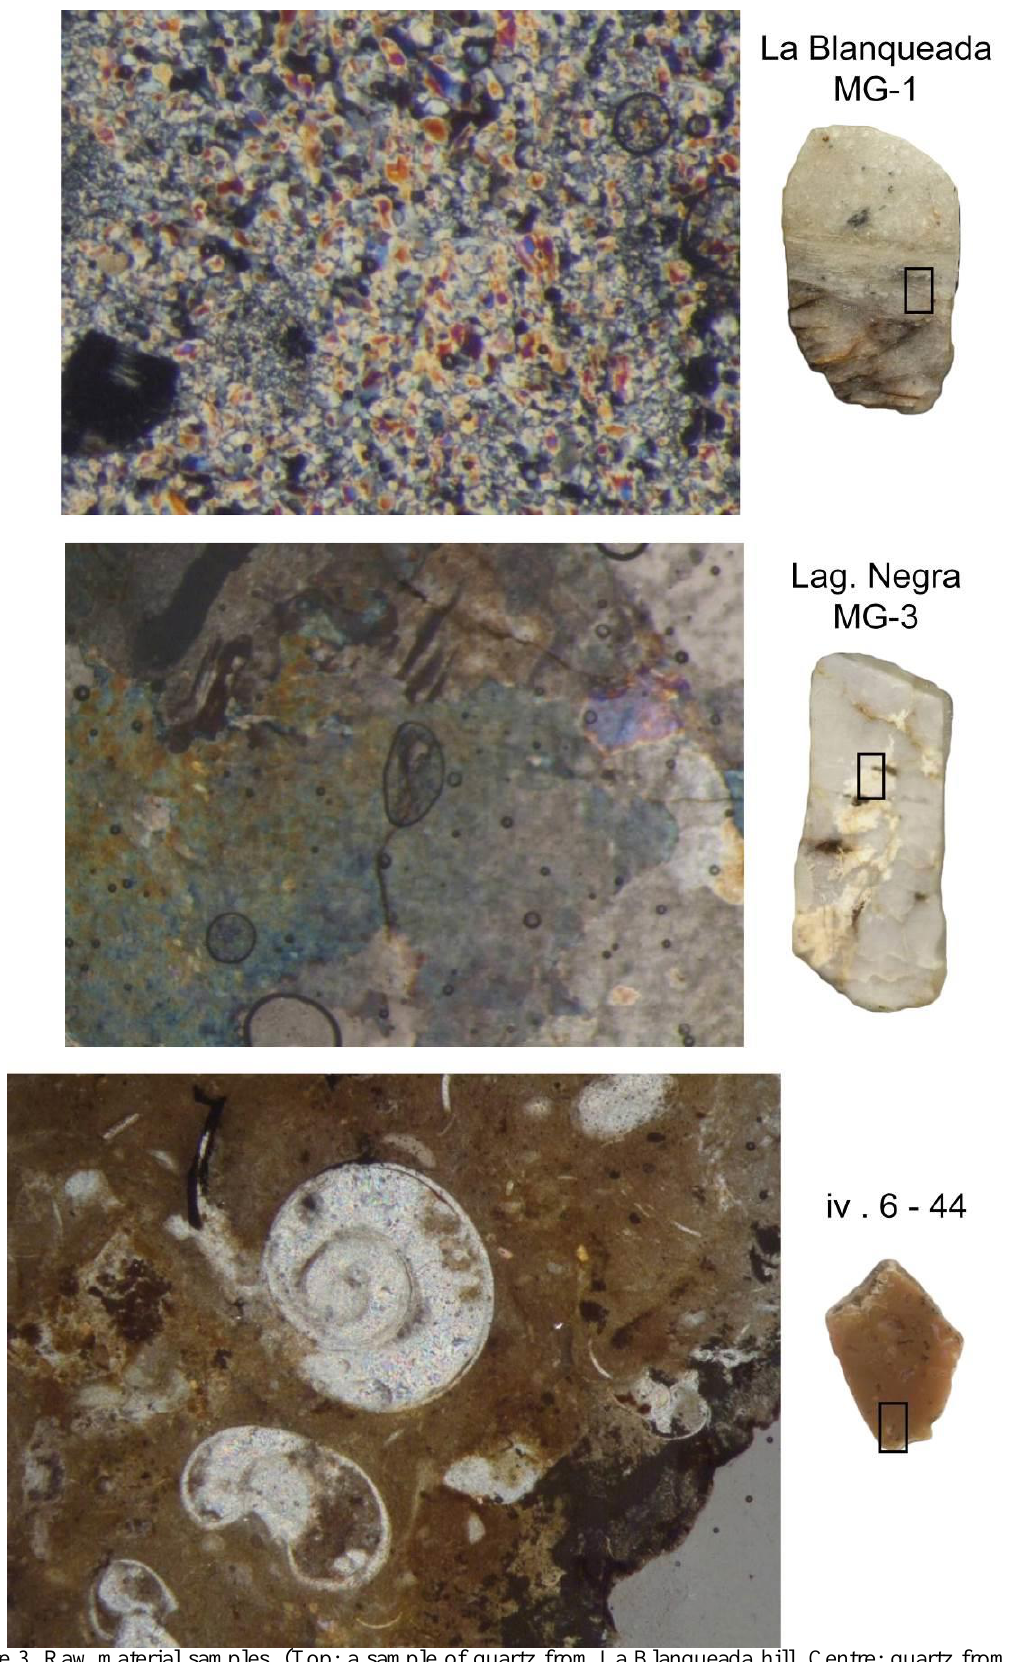
Figure 3. Raw material samples. (Top: a sample of quartz from La Blanqueada hill. Centre: quartz from Negra Lagoon. Bottom: archaeological chert) Scale x 100, cross-polarised